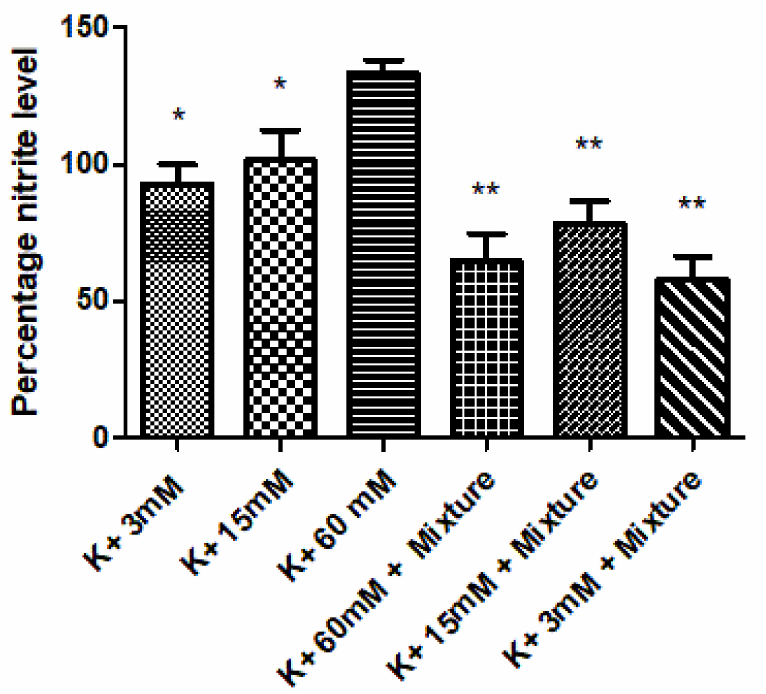
Figure 8. Inhibitory effect induced by the mixture (200 µ g/mL) on nitrite level, in isolated mouse cortex specimens. ANOVA, p < 0.001; ** p < 0.01, * p < 0.05 vs. K + 60